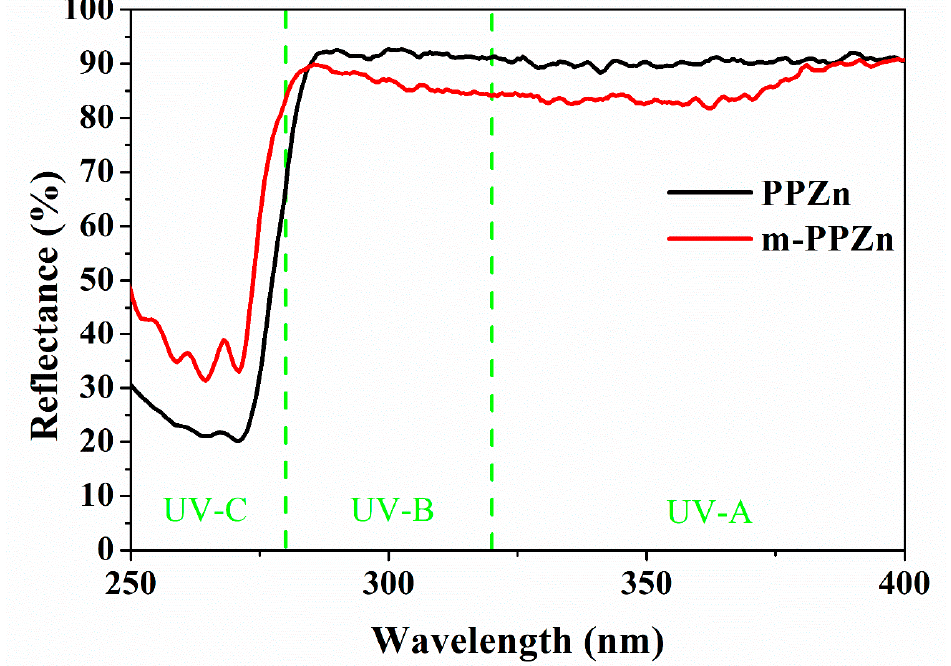
Figure 2. UV-Vis spectra of PPZn and m-PPZn.